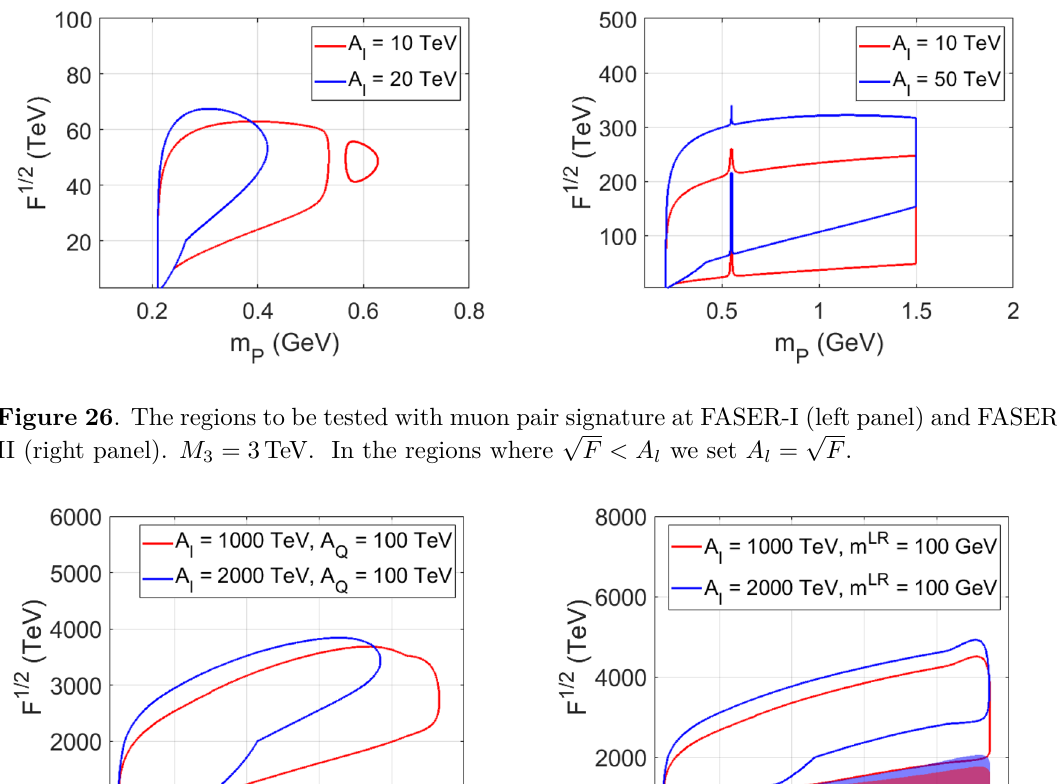
√ √ F < M γγ we set M γγ = F .